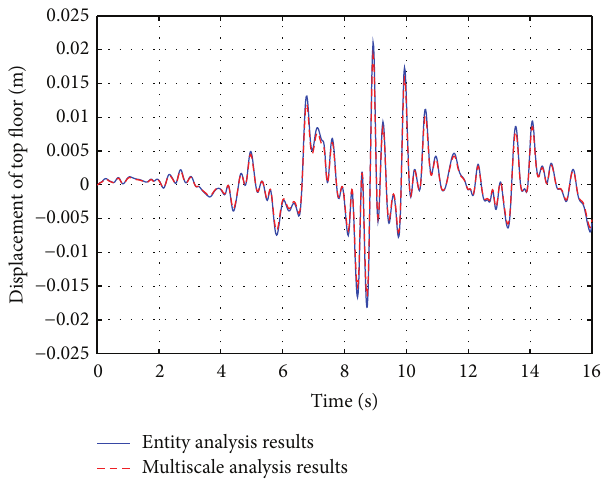
Figure 20: Displacement history of top floor.